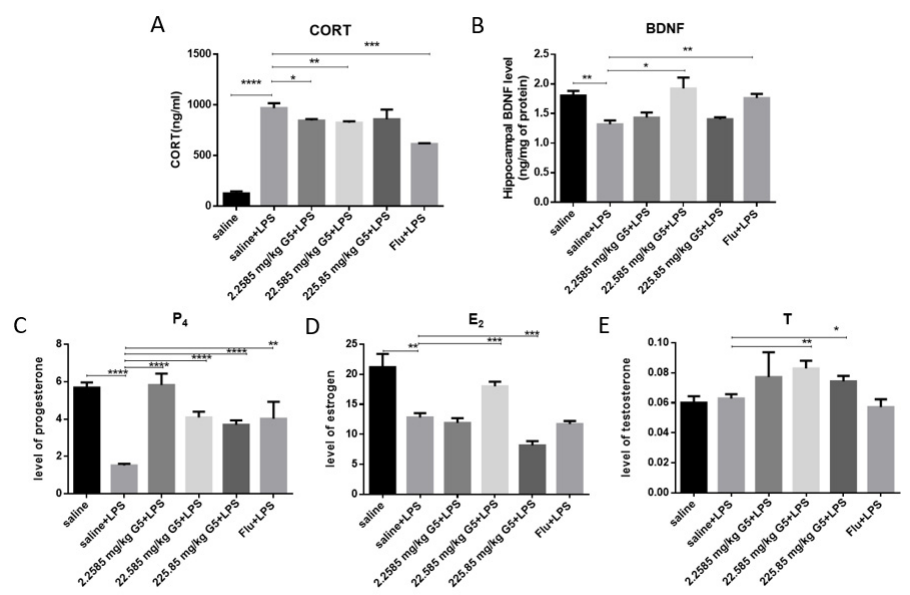
Figure 5. Effect of G5 pre-treatment in LPS challenged animals on serum and level of progesterone (P4), estrogen (E2), and testosterone (T) in LPS-induced depression mice. The concentrations of serum CORT ( A ) and hippocampal BDNF level ( B ). Serum was collected 4 h post-LPS challenge and subjected to ELISA kit to detect CORT. The concentrations of serum P4 ( C ), E2 ( D ), and T level ( E ). Hippocampi and mPFC were collected 48 h post-LPS challenge and subjected to ELISA kit to detect BDNF. Serum were collected 48 h post-LPS challenge and subjected to RIA kit. For statistical significance, * p < 0.05, ** p < 0.01, *** p < 0.005, **** p < 0.001 for one-way ANOVA followed by Fisher’s least significant difference test; n = 7, all data are presented as mean ±